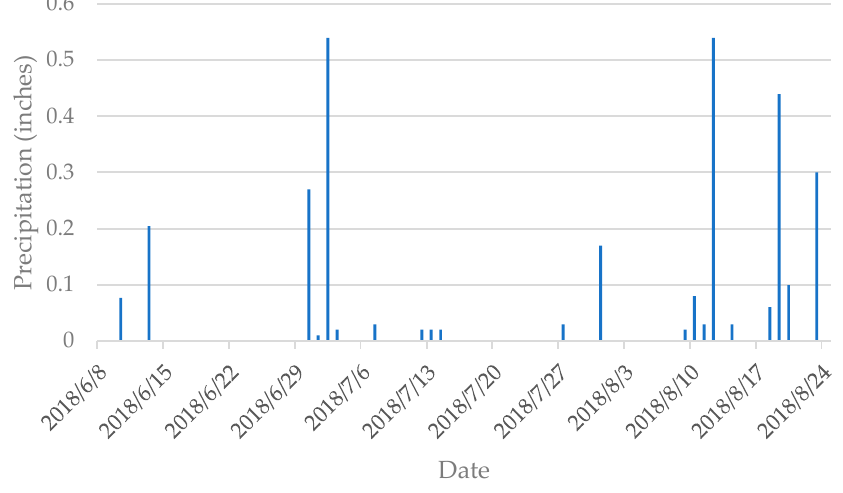
Figure 2. Seasonal pattern of precipitation during the cotton growing season.